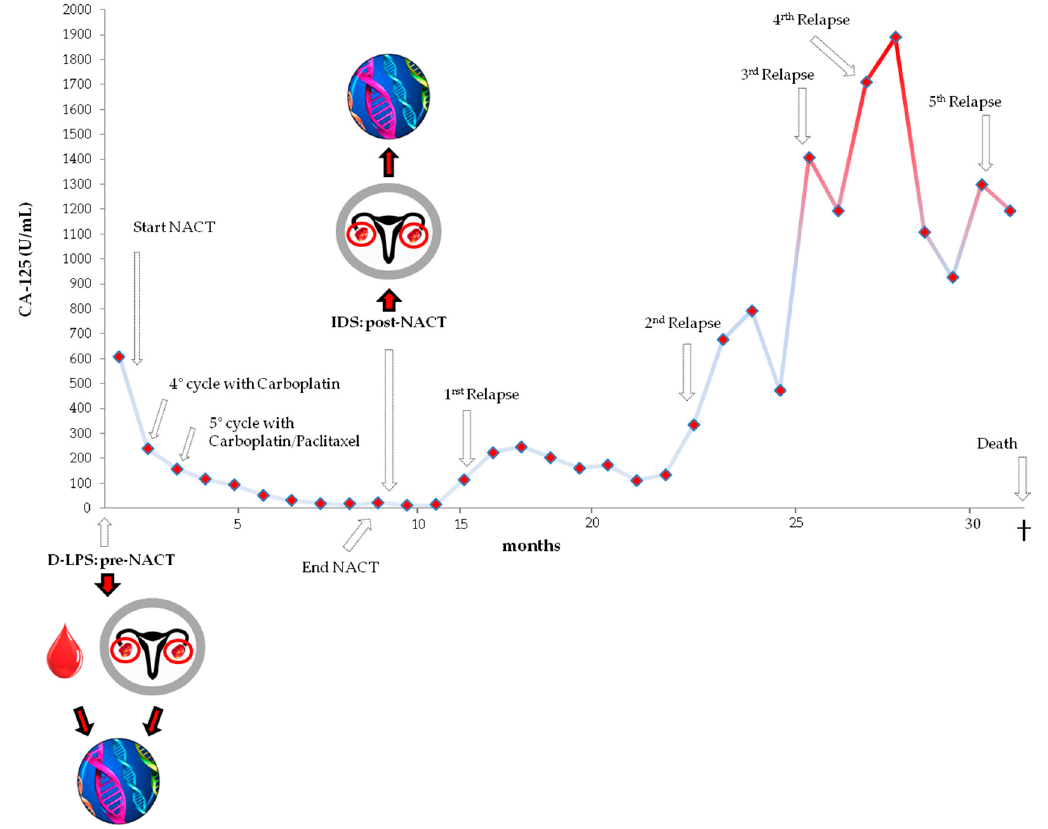
Figure 1. Graphical representation of CA-125 levels across the disease/treatment course of the patient diagnosed with HGSOC. The two time points, at D-LPS (pre-NACT) and at IDS (post-NACT), in which blood and ovarian tumor tissue samples were collected, are highlighted. CA-125: cancer antigen 125; D-LPS: diagnostic laparoscopy; NACT: neo-adjuvant chemotherapy; IDS: interval debulking surgery; HGSOC: high-grade serous ovarian cancer.